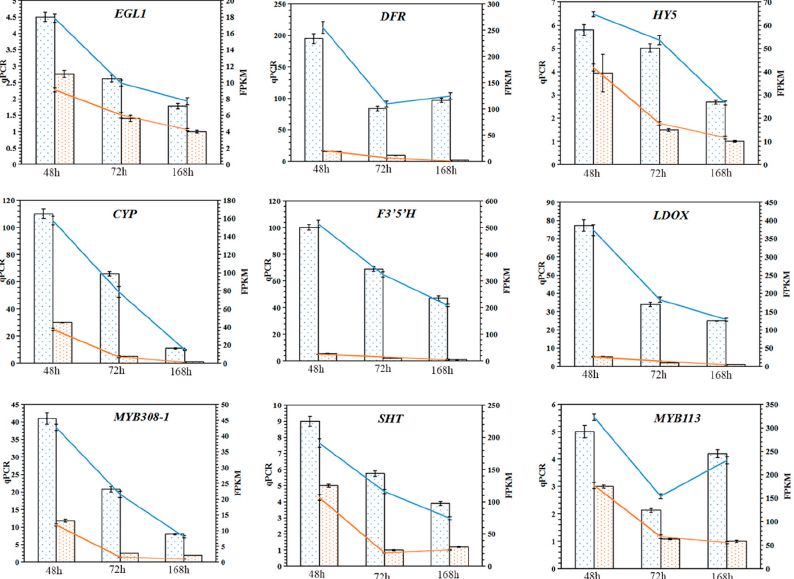
Figure 9. qPCR validation of genes involved in anthocyanin synthesis. The expression profiles of 9 genes were measured by RNA-seq and qRT PCR. These nine genes include structural genes and transcription factors related to the flavonoid pathway. The histogram data represent qRT PCR data (left Y-axis) and the broken line represents RNA-seq data (right Y-axis). Blue dots in the histogram represent light treatment and orange dots represent dark treatment. The x-axis in each chart repre- sents three-light treatment stages (48 h, 72 h, and 168 h). The qRT PCR assay had three biological replicates, each with three technical replicates ( n = 9). The FPKM value of RNA-seq has three bio- logical repetitions ( n = 3). The error bars indicate the standard deviation.